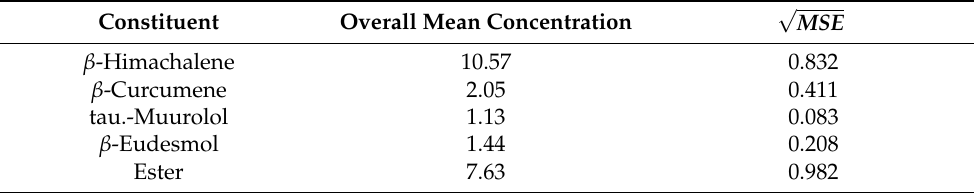
Table 7. Overall mean H. italicum concentration (%) of β -Himachalene, β -Curcumene. tau.-Muurolol, β -Eudesmol, and Ester where there was no significant difference among the three collections.